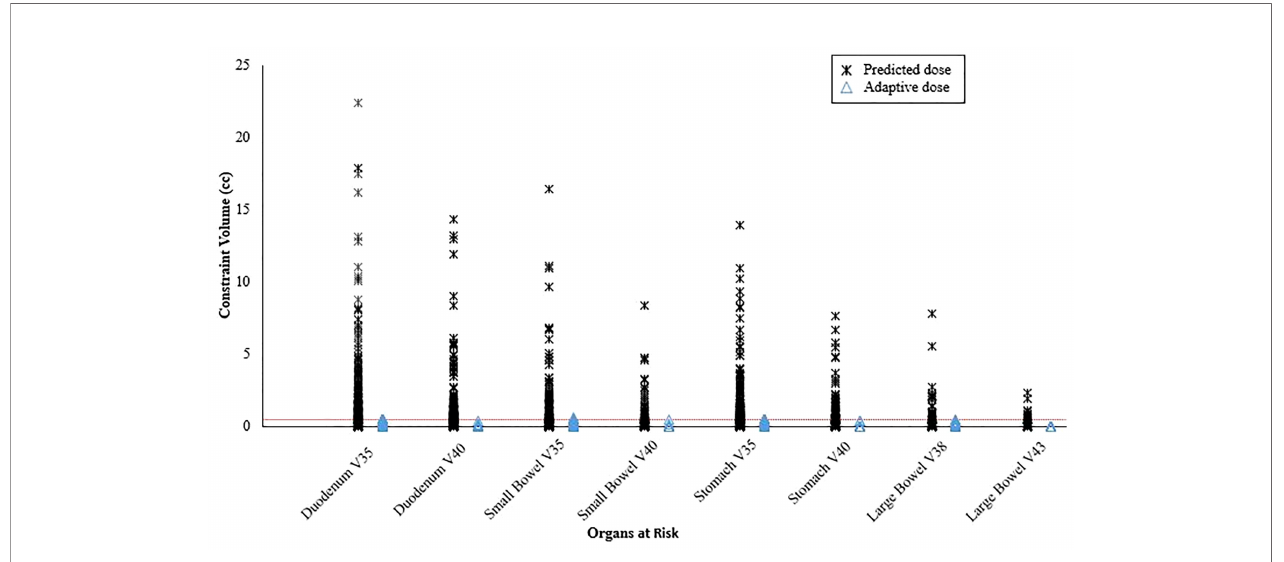
FIGURE 2 | Predicted organ at risk dose/volumes assuming the original plan was used on the day of treatment anatomy compared to on-table adaptive replanning that was able to ensure all dose constraints were met for every fraction. The horizontal dotted line represents the constraint volume of 0.5